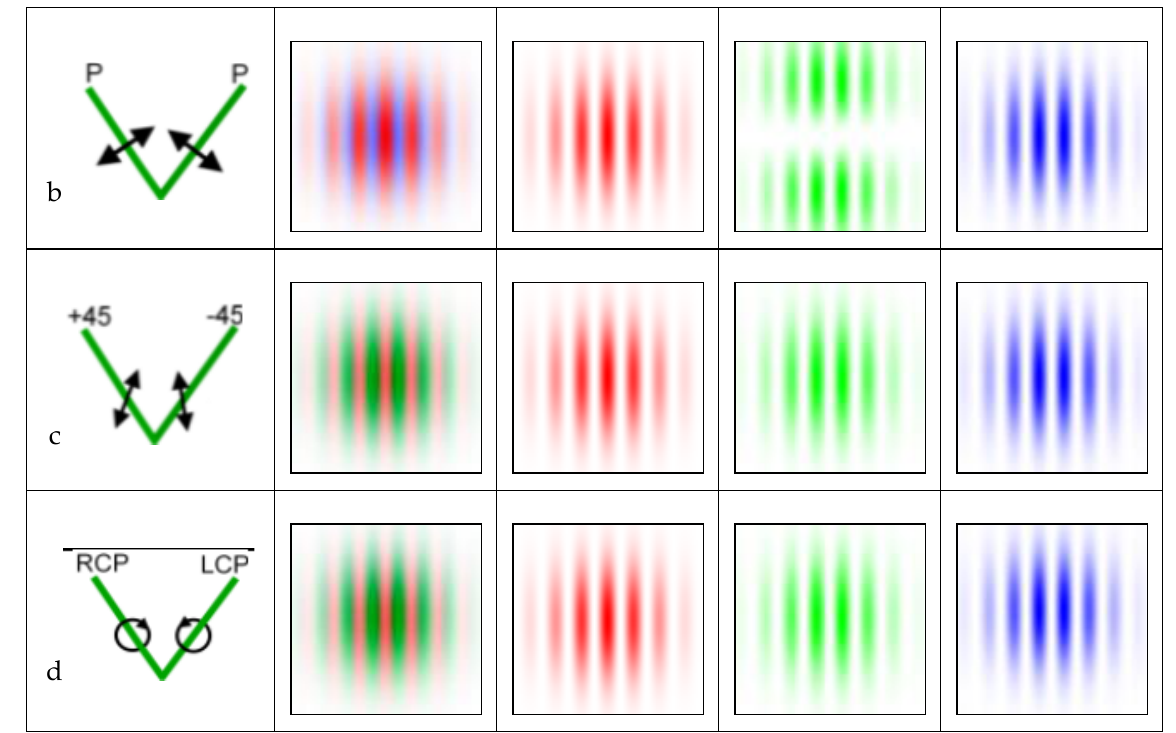
Figure 1. Results of interference of two shifted differently polarized Gaussian beams: ( a ) linear S-polarization; ( b ) linear P-polarization; ( c ) linear polarization at incidence angles of +45 ◦ and − 45 ◦ ; ( d ) circular right- and left-handed polarizations (focused electric field components: | E x | 2 —red; E 2 —green; and | E z | 2 —blue).